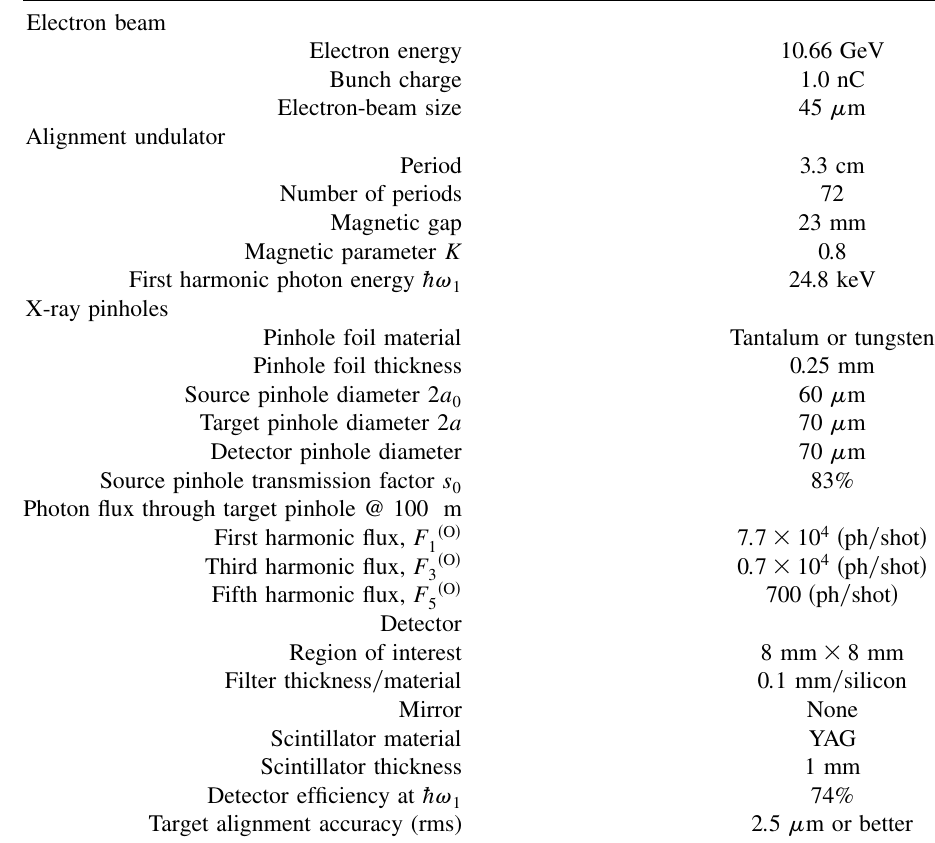
TABLE IV. Design parameters for LCLS x-ray alignment with a dedicated undulator source. Electron